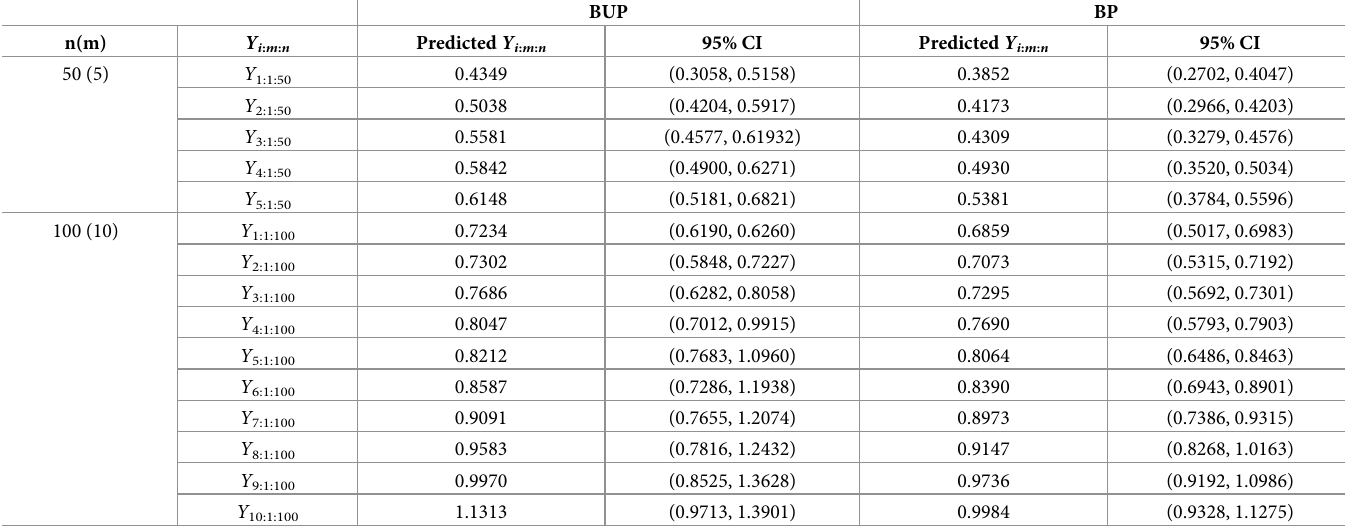
Table 7. Point and interval prediction of the unobserved order statistics Y